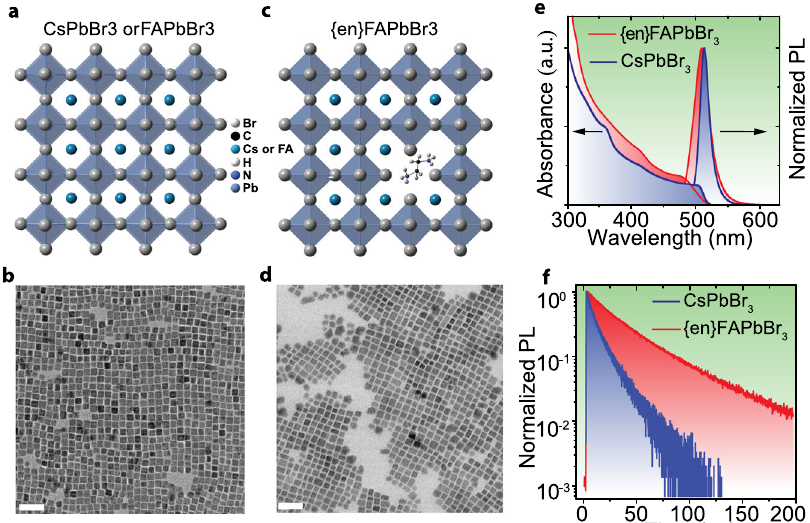
Fig. 1 Colloidal perovskite NCs and their optical properties. Structural and morphological comparison of CsPbBr 3 and {en}FAPbBr 3 . a , c Schematic of the structural difference between the undoped and {en}-doped (hence hollow) perovskite NCs; octahedral tiltings in CsPbBr 3 are omitted for simplicity. b , d TEM images of CsPbBr 3 NCs and {en}FAPbBr 3 NCs (scale bar is 20 nm). e Absorption and PL spectra and f time-resolved photoluminescence traces for CsPbBr 3 (blue) and {en}FAPbBr 3 (red)